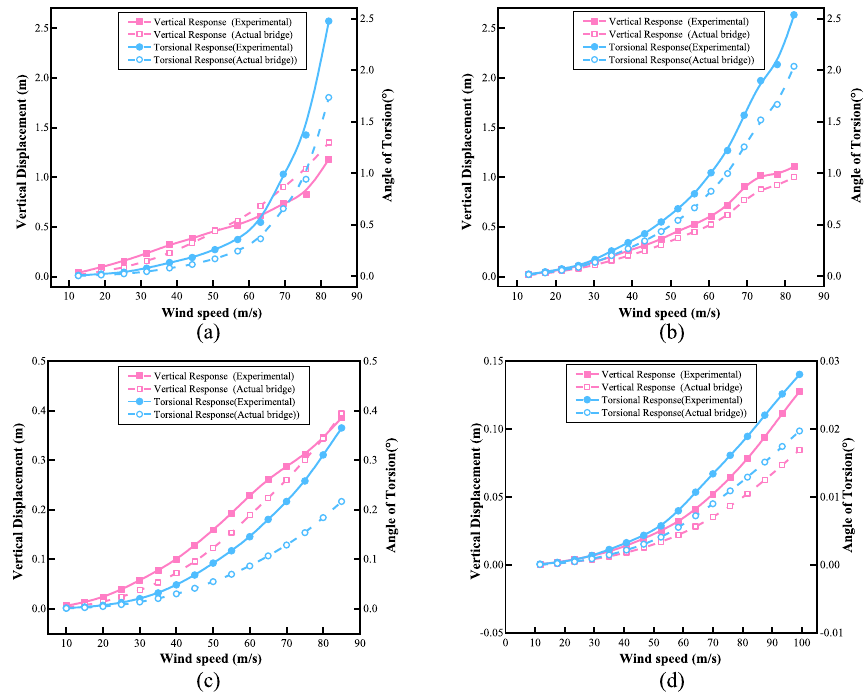
Fig. 16 Buffeting response root-mean-square values of the three typical bridges. a RMS value of bridge A (1:40). b RMS value of bridge A (1:208). c RMS value of bridge B . d RMS value of bridge